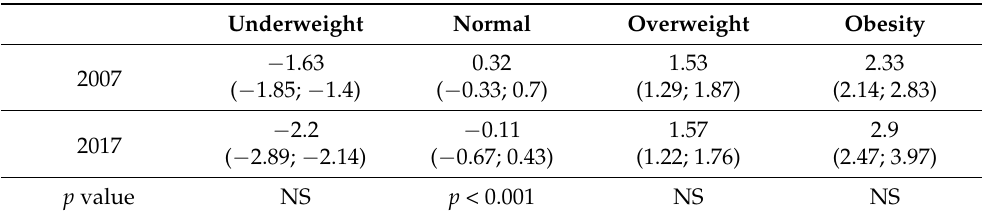
Table 2. BMI z-score in 4 weight categories (underweight, normal, overweight, and obesity). Values are medians (lower quartile and upper quartile).